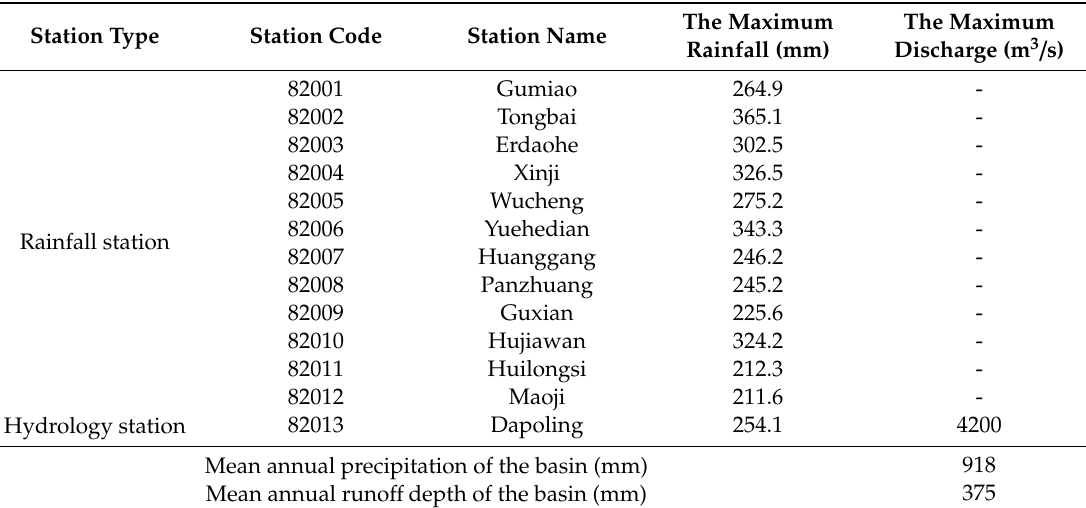
Table 1. The data and stations of Dapoling basin.